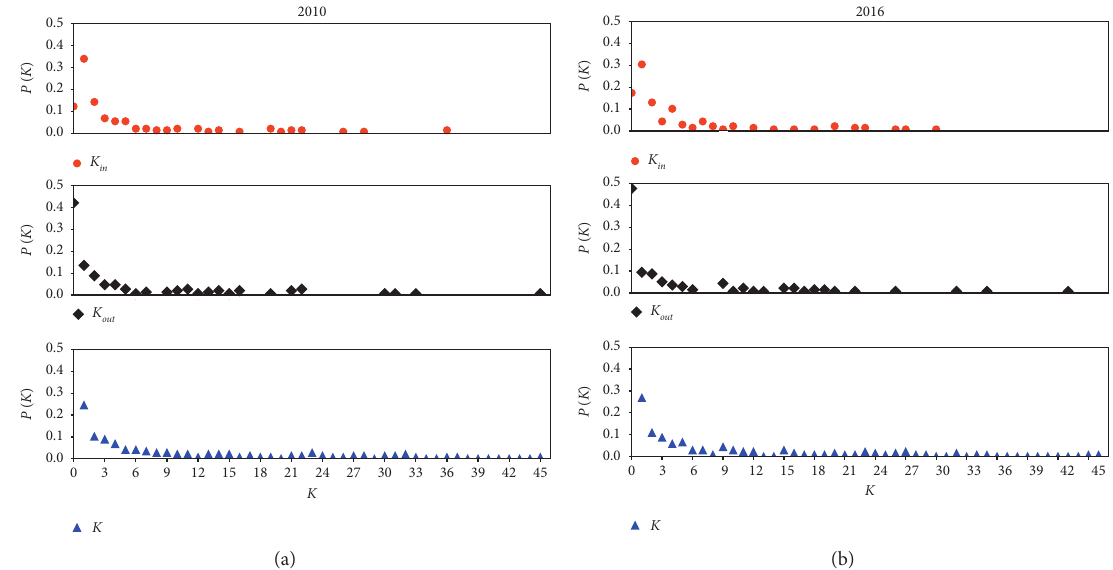
Figure 5: The in-degree, out-degree, and degree distributions of the global crude oil trade network before optimization: (a) 2010; (b) 2016.